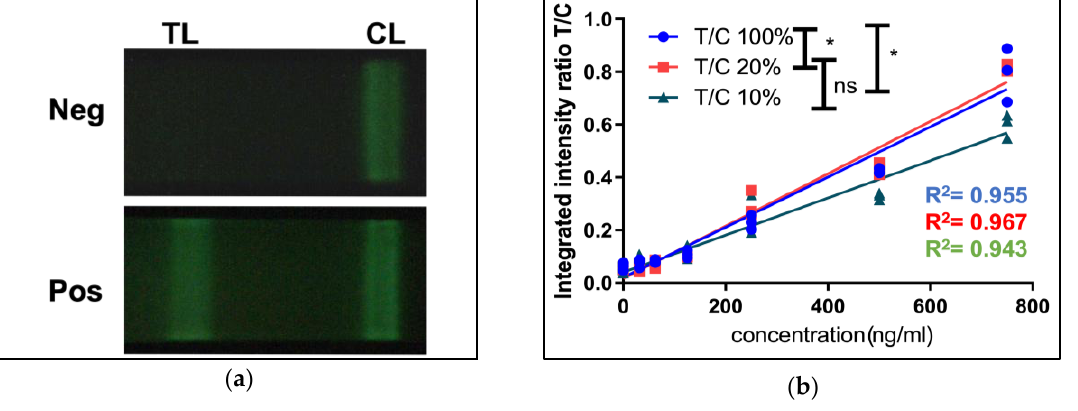
Figure 9. Effect of battery charge level on the performance of nanophosphor-based LFA. ( a ) Typical images of negative (top; no-analyte) and positive (bottom; 500 ng mL − 1 ) nanophosphor-based LFA strips. Nanophosphor-based LFA strips were excited by the flash on an iPhone 5s smartphone and the images were immediately captured using the built-in camera to capture the emitted light from the test line (TL) and control line (CL) as described in Methods. ( b ) T/C ratios of cystatin C titration series imaged with an iPhone 5s and the LFA attachment under 3 battery charge levels (<10%, 15–25%, and 100%). *, p < 0.05, ns, p > 0.05 as determined using paired t -test.